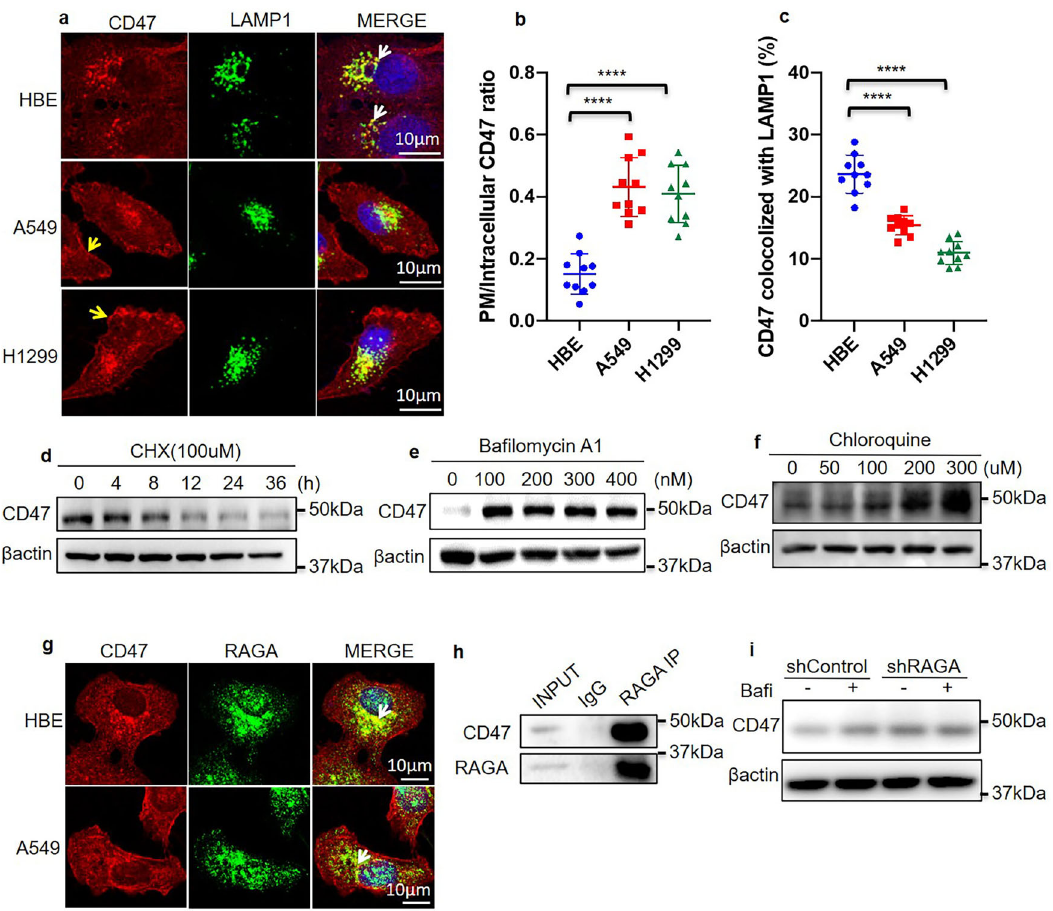
Fig. 4 RAGA promotes CD47 lysosome degradation. a Immuno fl uorescence staining of CD47 and LAMP1 in HBE, A549, and H1299 cells. The yellow arrow indicates cell surface CD47 staining. The white arrow indicates the colocalization of CD47 with LAMP1. b Statistical analysis of PM/intracellular CD47 expression ratio ( n = 10 cells per group). c Statistical analysis of the percentage of CD47 colocalized with LAMP1 ( n = 10 image areas per group). d Immunoblot analysis of the indicated proteins in 100 μ M cycloheximide (CHX) treated A549 cells. h indicates hours. e Immunoblot analysis of the indicated proteins in A549 cells treated with different dosages of ba fi lomycin A1. f Immunoblot analysis of the indicated proteins in A549 cells treated with different dosages of chloroquine. g Immuno fl uorescence staining of CD47 and RAGA in HBE and A549 cells. The white arrow indicates the colocalization of CD47 with RAGA. h Immunoblot analysis of indicated proteins assessed after RAGA immunoprecipitation. i Immunoblot analysis of indicated proteins in control and RAGA knockdown A549 cells treated with or without ba fi lomycin A1. Ba fi indicates ba fi lomycin A1. Data were from two independent experiments. Statistical data were presented as mean ± SD. P < 0.05 is considered statistical signi fi cance. **** indicates P <